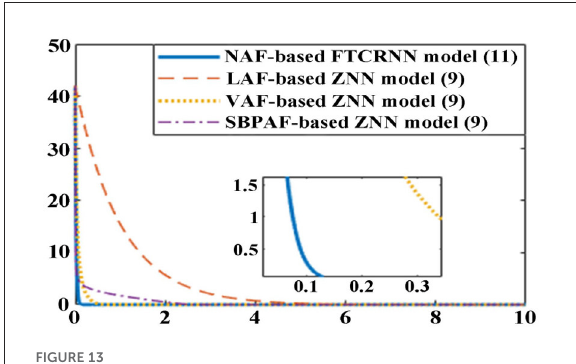
FIGURE13 Residual errors of the ZNN model (9) and the NAF-based FTCRNN model (11) for solving TODSE without